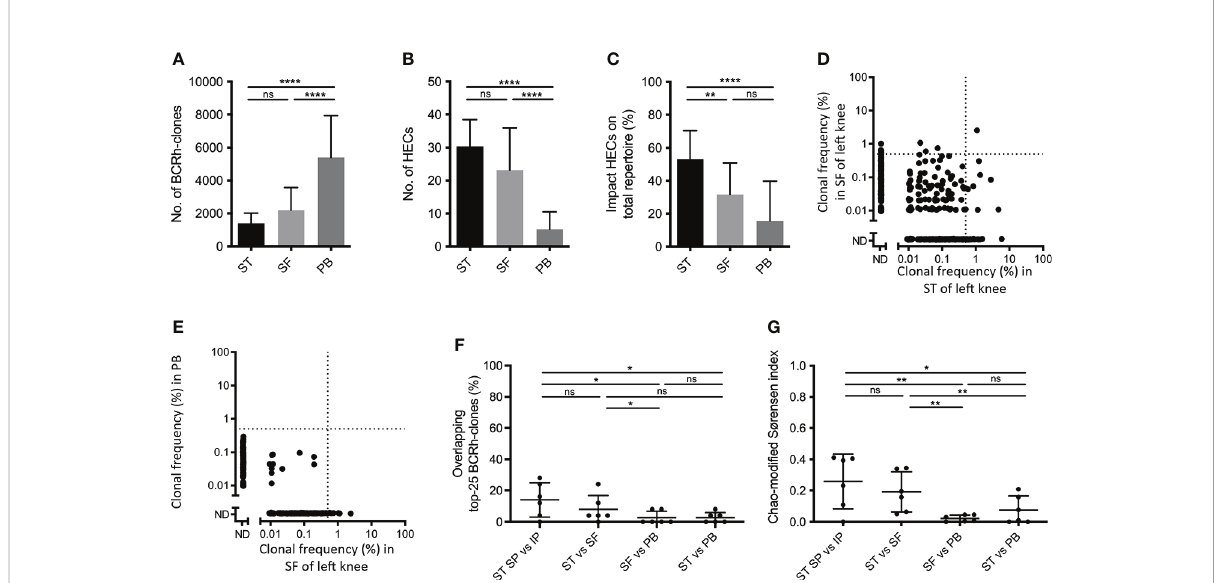
FIGURE 3 Comparing B-cell receptor repertoires in synovial tissue, synovial fl uid and peripheral blood. Bar charts of (A) the number of BCR-clones, (B) number of highly expanded BCR-clones (HECs) and (C) impact of HECs on total repertoire per compartment (bars show mean and SD; **